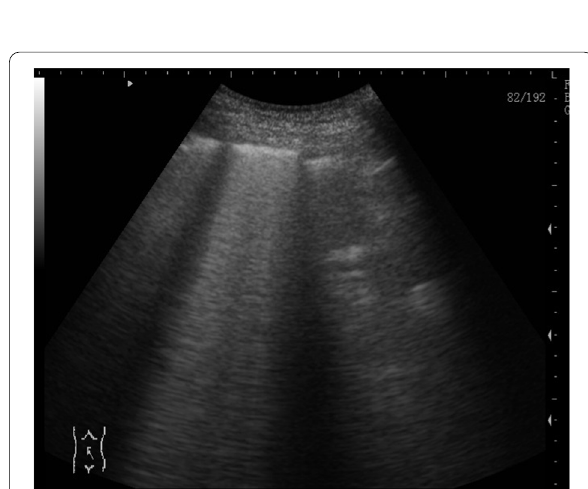
Fig. 3 LUS of a non-COVID-19 patient showed areas of consolidation with small areas of air bronchogram and thick smooth pleural line. B-lines were few and not so